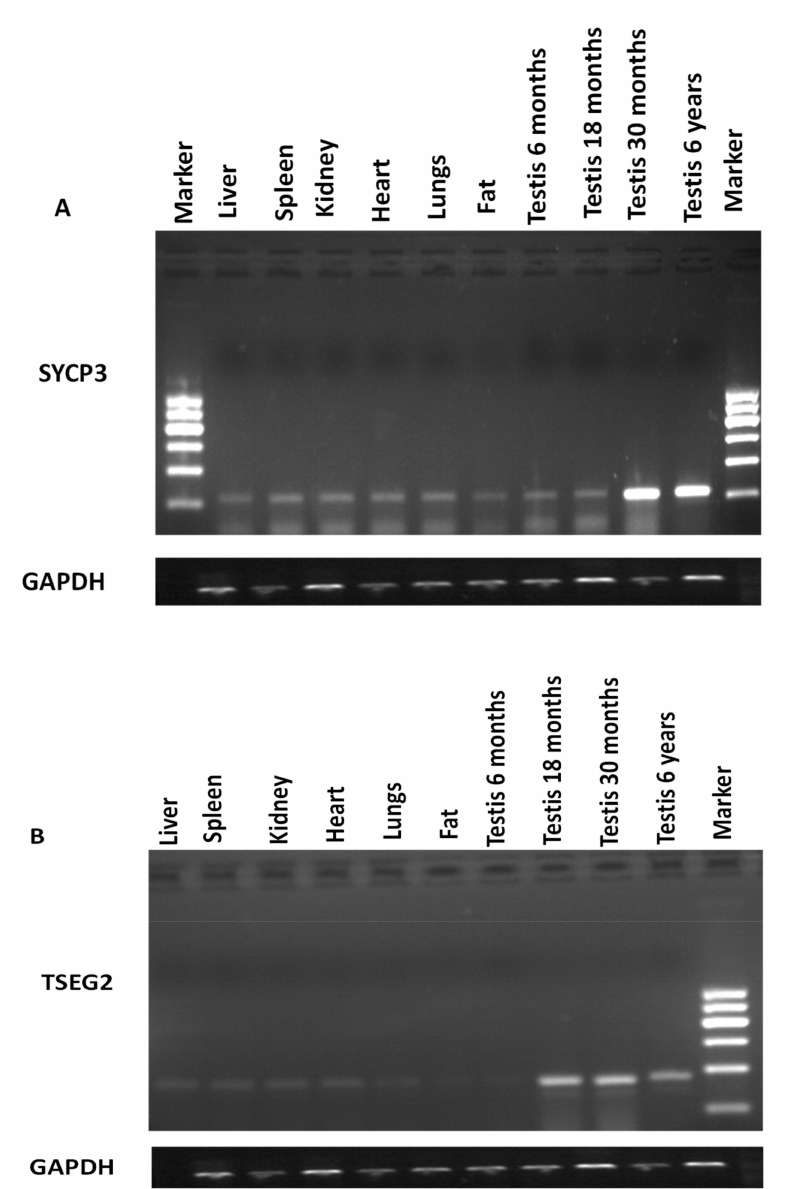
Figure 1. Analysis of the SYCP3 and TSEG2 mRNA using semi-quantitative PCR from di ff erent tissues of Datong yak ( A ) SYCP3 expression ( B ) TSEG2